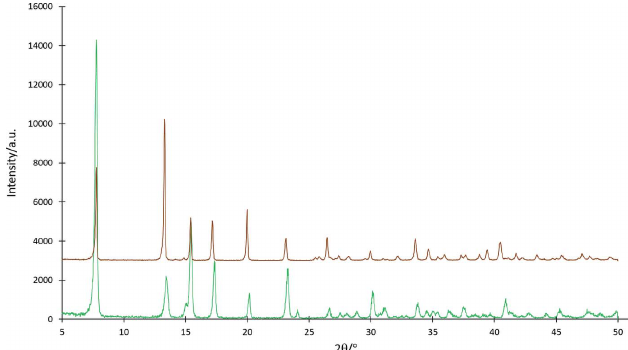
Figure 7 Overlay of the PXRD traces of [CdCl 2 (4-pym) 2 ] n ( 4 ) (experimental;